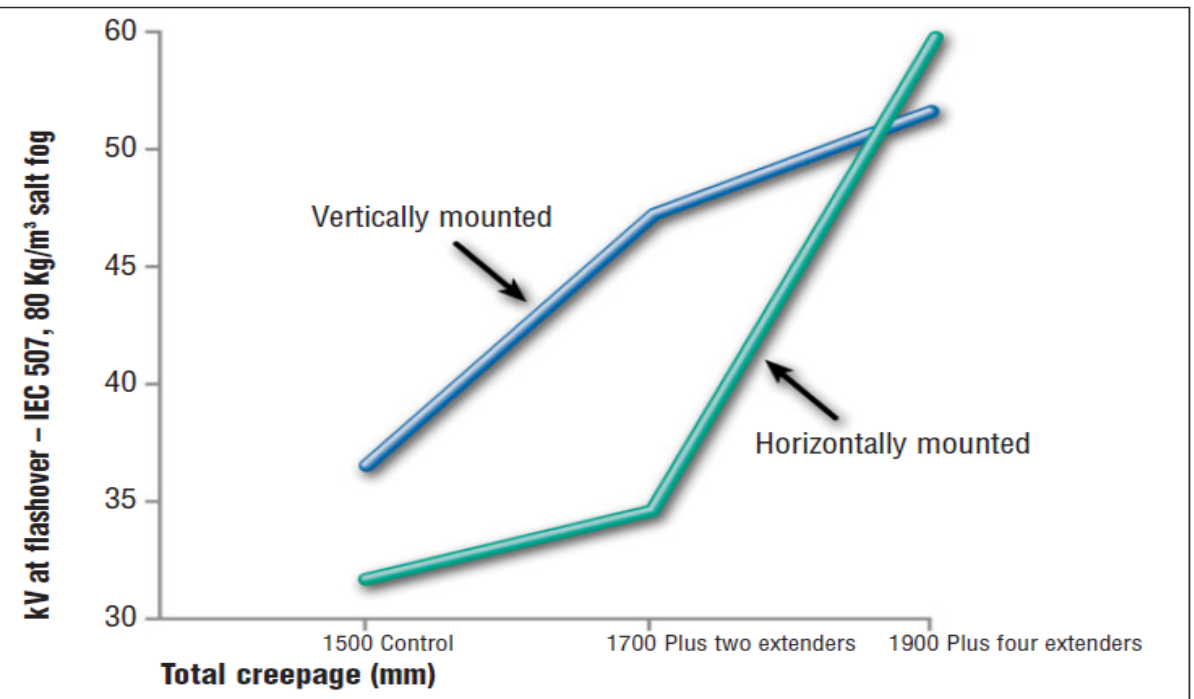
Figure 1. Flashover voltage against the number of extenders of a post insulator at 66 kV [9].